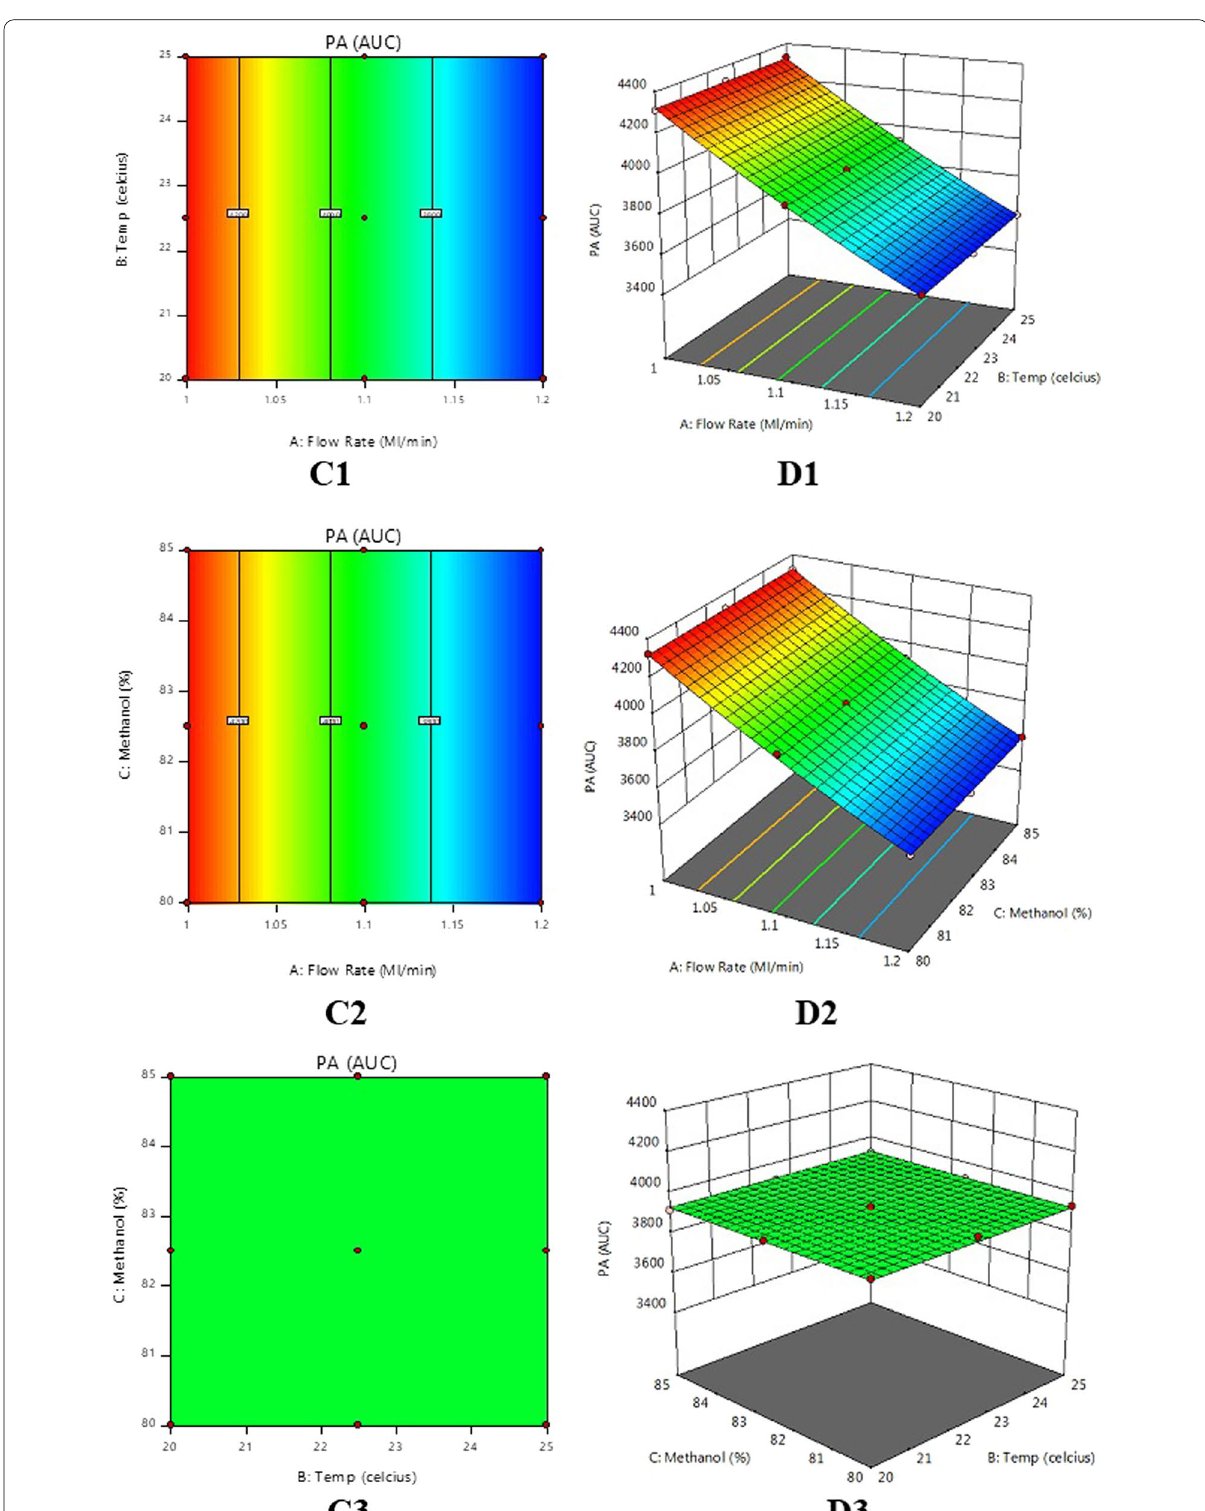
Fig. 5 Relation plot (C1-C3; D1-D3) between true with predicted values and residual plot for